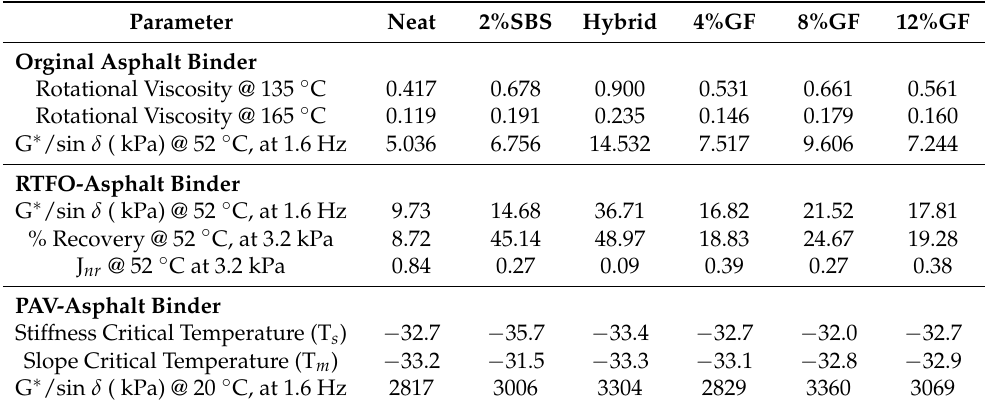
Table 5. Asphalt binder properties.